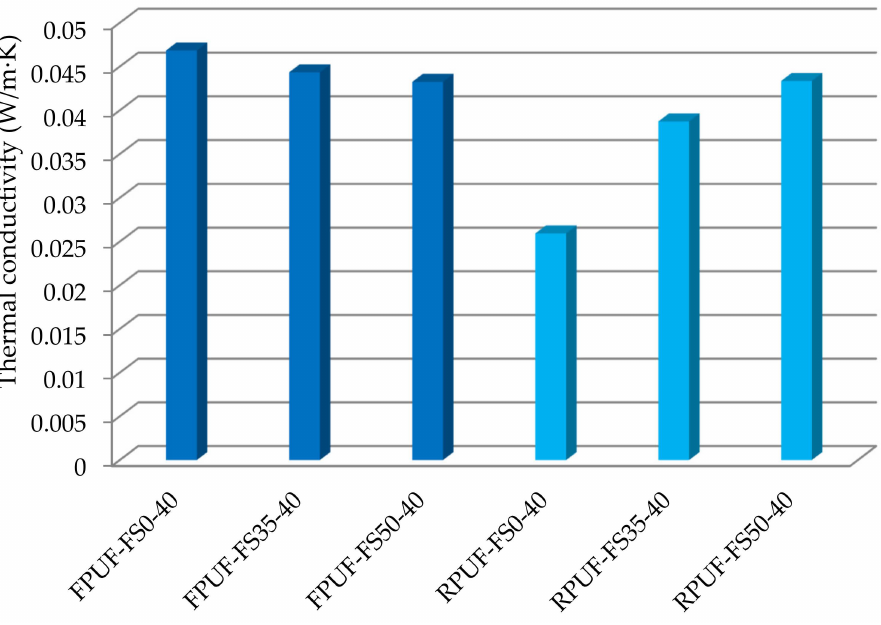
Figure 13. Thermal conductivity of obtained